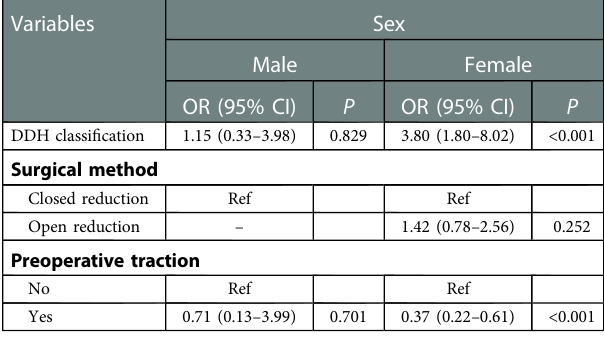
TABLE 5 Association of DDH classi fi cation and preoperative traction with postoperative ANFH in sex subgroups. Variables